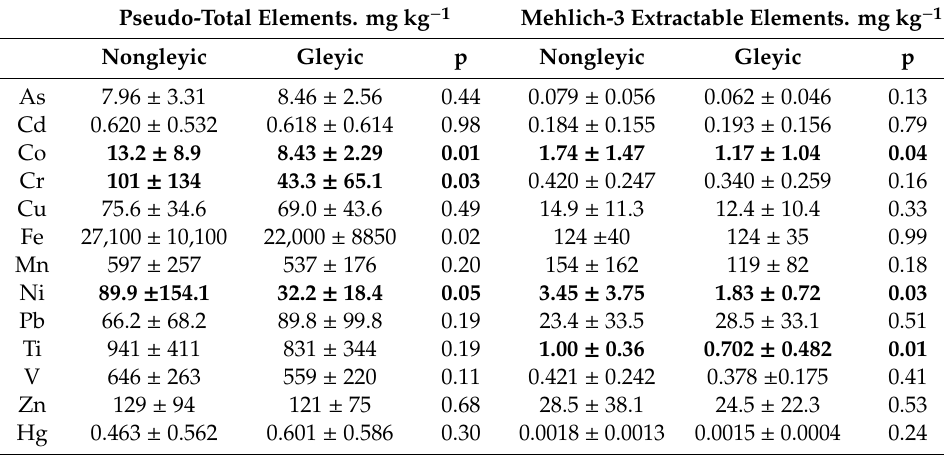
Table 7. Mean values and standard deviations of the concentrations (mg kg − 1 ) of pseudo-total and Mehlich-3 extractable PTEs of the urban soils studied, without gleyic properties (n = 62) and with gleyic properties (n = 29), and significance of equality of means (T-test). Significant di ff erences (p ≤ 0.05) highlighted in